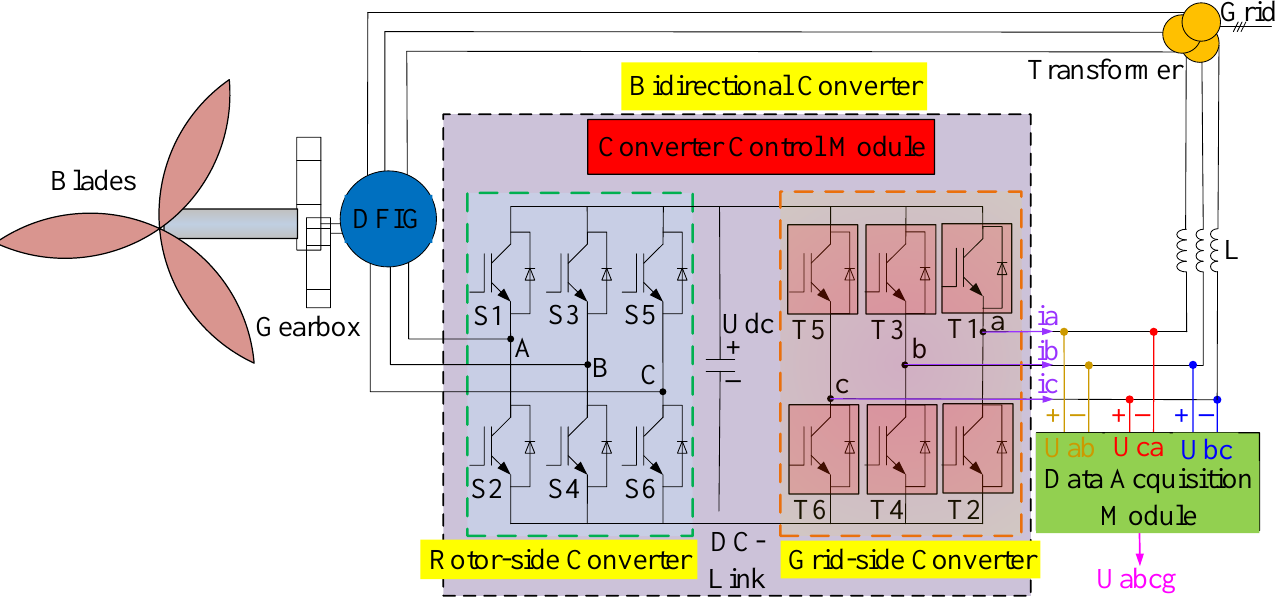
Figure 2. The topology of a wind turbine system.